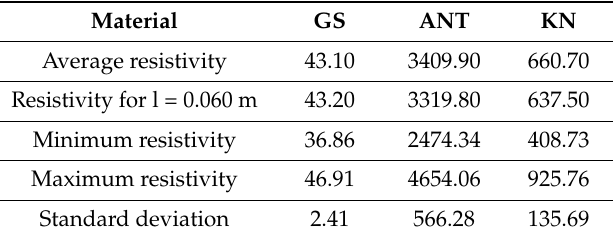
Figure 7. KN material resistivity for various measuring electrode distances l; m. Table 4. Average resistivity value of the analysed